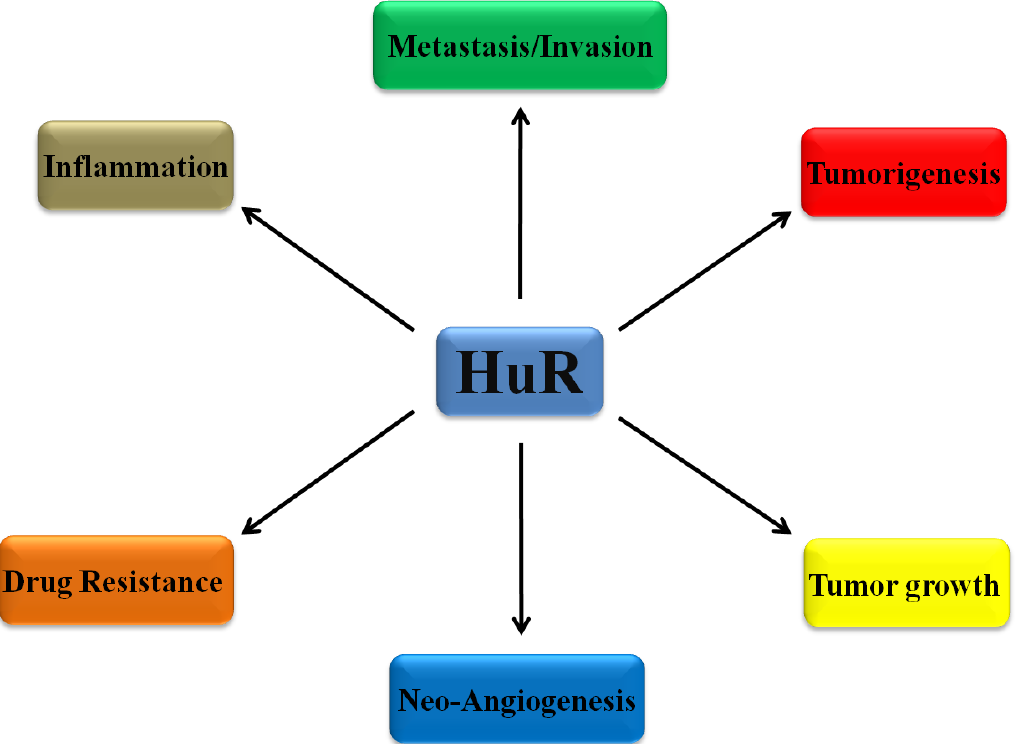
Figure 2. The diverse role of HuR in cancer development and progression through the regulation of the stability and/or translation of target mRNAs that control metastatic invasion properties of cancer cells, angiogenesis, tumor growth, inflammation and tumor resistance against multiple agents.